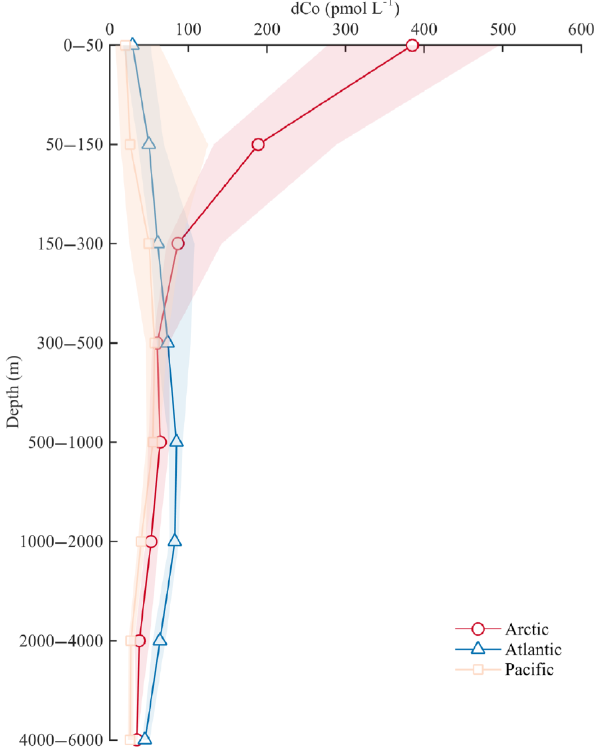
Figure 3. Median dCo concentrations at specific depth intervals from the Arctic Ocean (this study; red circles), Atlantic Ocean (blue triangles), and the Pacific Ocean (orange squares). Shaded regions indicate the upper and lower quartiles of the data in each